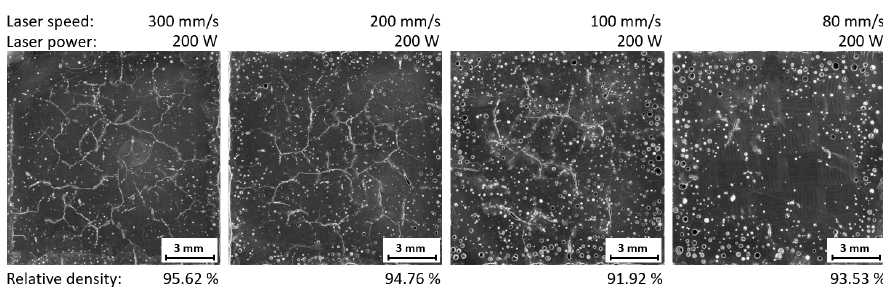
Figure 14. Metallography of samples with higher platform heating and chessboard strategy.